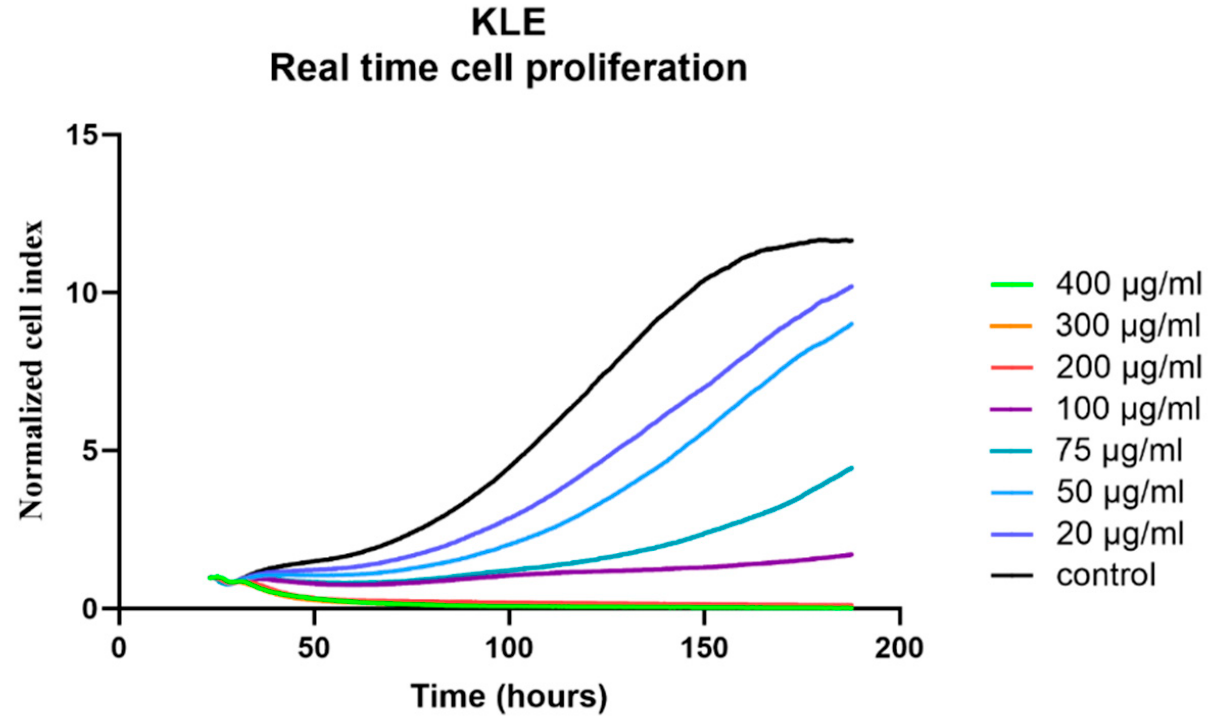
Figure 3. Real-time evaluation of the effects of Cimicifuga racemosa on KLE cell proliferation. Mean values of two independent experiments are shown.